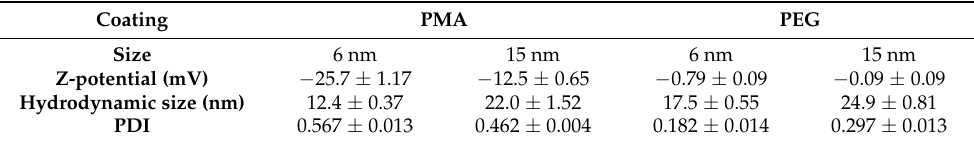
Table 1. Characterization of GNP@PEG and GNP@PMA by dynamic light scattering (DLS). Z- potential, hydrodynamic size (distribution in number), and polydispersity index (PDI) as measured by DLS. Mean ± SD of three independent